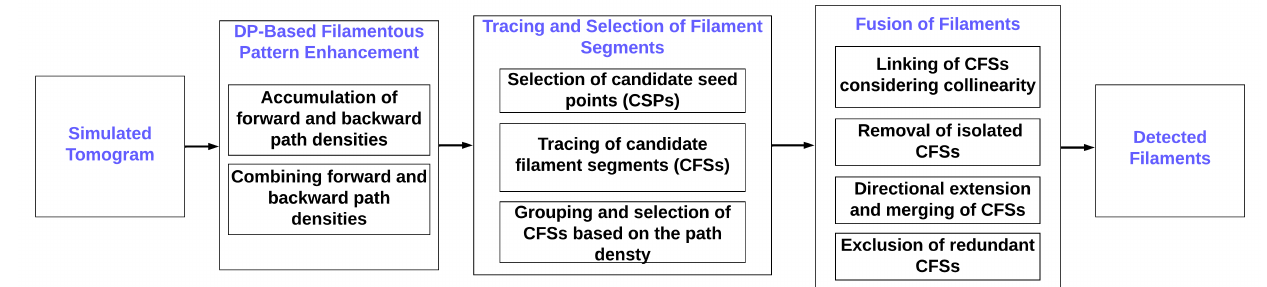
Figure 1. The filament-tracing framework originally developed in [19]. The enhancement step filters the tomogram by utilizing a cumulative path-based density-contrast enhancement algorithm. This relatively slow preprocessing step raises the intensity values of filaments to make them stand out better from the noise. Subsequently, the filaments can be quickly generated in a bottom-up manner from candidate seed points (CSPs), which is followed by tracing short candidate filament segments (CFSs) from the CSPs. The large number of short CFSs are then refined and fused to generate the detected output